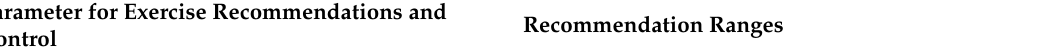
Table 3. Moderate continuous aerobic endurance training (MCT): training parameters for exercise recommendations and exercise training control